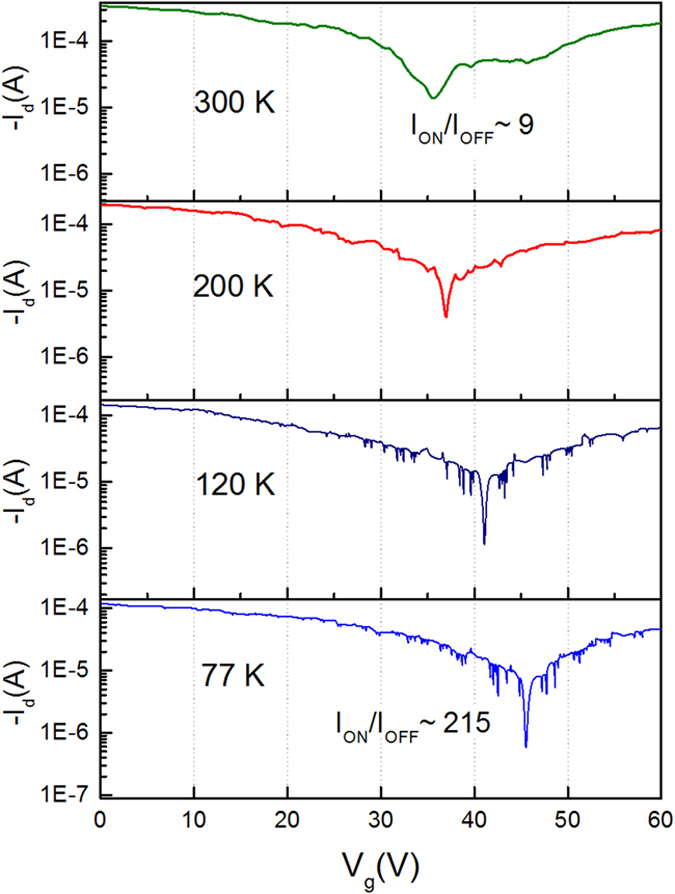
Temperature study of GNM transfer characteristics.Comparison of Id−Vg curves of the GNM-FET with ~10 nm neck width recorded at Vds = −1 V and at different temperatures 300, 200, 120, and 77 K.